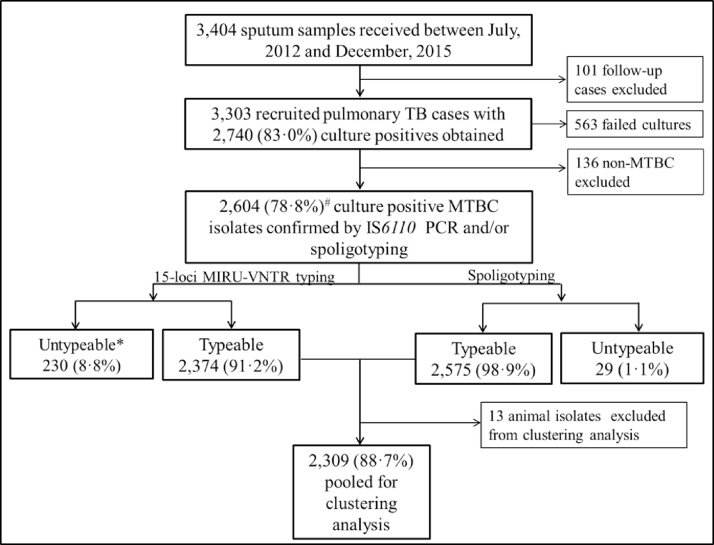
Pipeline for recruited participants and culture-positive TB cases included in the clustering analysis.*Category described as untypeable for MIRU-VNTR includes isolates with ≥2 MIRU loci unamplified (n = 164, 71.3%) and isolates with a double allele at ≥2 MIRU loci (n = 66, 28.7%). These isolates were described as suspected mixed infection or laboratory contamination and hence were excluded from further analysis.#Frequency was expressed as the total number of Mycobacterium tuberculosis complex (MTBC) isolates obtained.